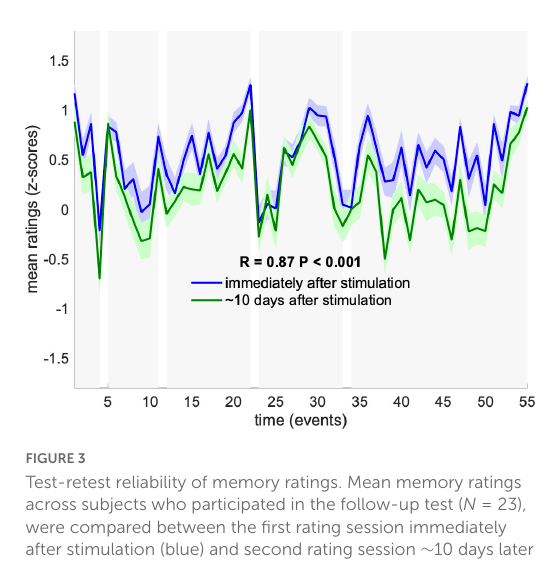
FIGURE3 Test-retest reliability of memory ratings. Mean memory ratings across subjects who participated in the follow-up test ( N = 23), were compared between the first rating session immediately after stimulation (blue) and second rating session ∼ 10 days later (green). Dynamics were significantly correlated across rating sessions ( P < 0.001). Ratings are presented as mean and SEM across subjects.